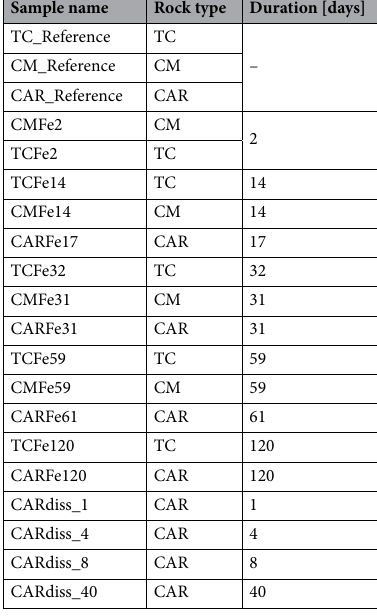
Table 2. Overview of experiments conducted in this